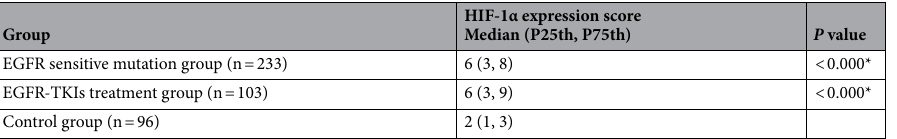
Table 2. The expression of HIF-1α in EGFR sensitive mutation group, EGFR-TKIs treatment group and control group. *Compare with control group.